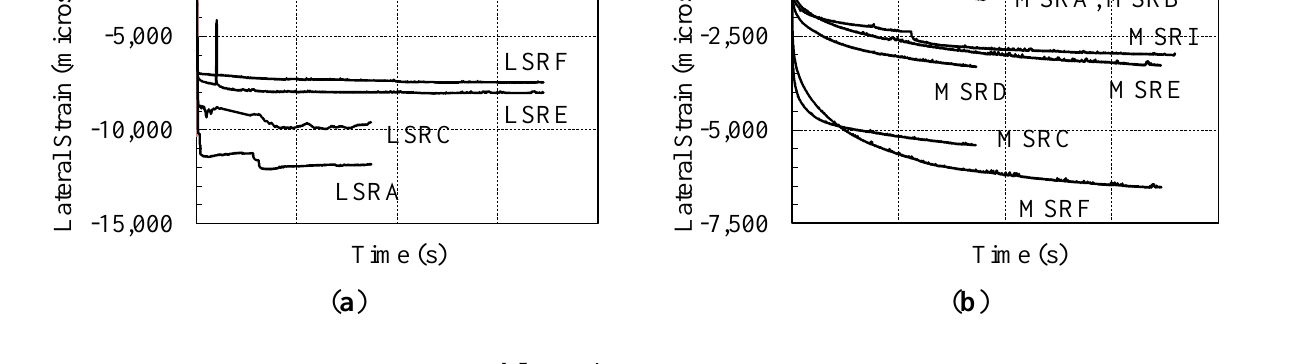
Table 2. Short-term creep